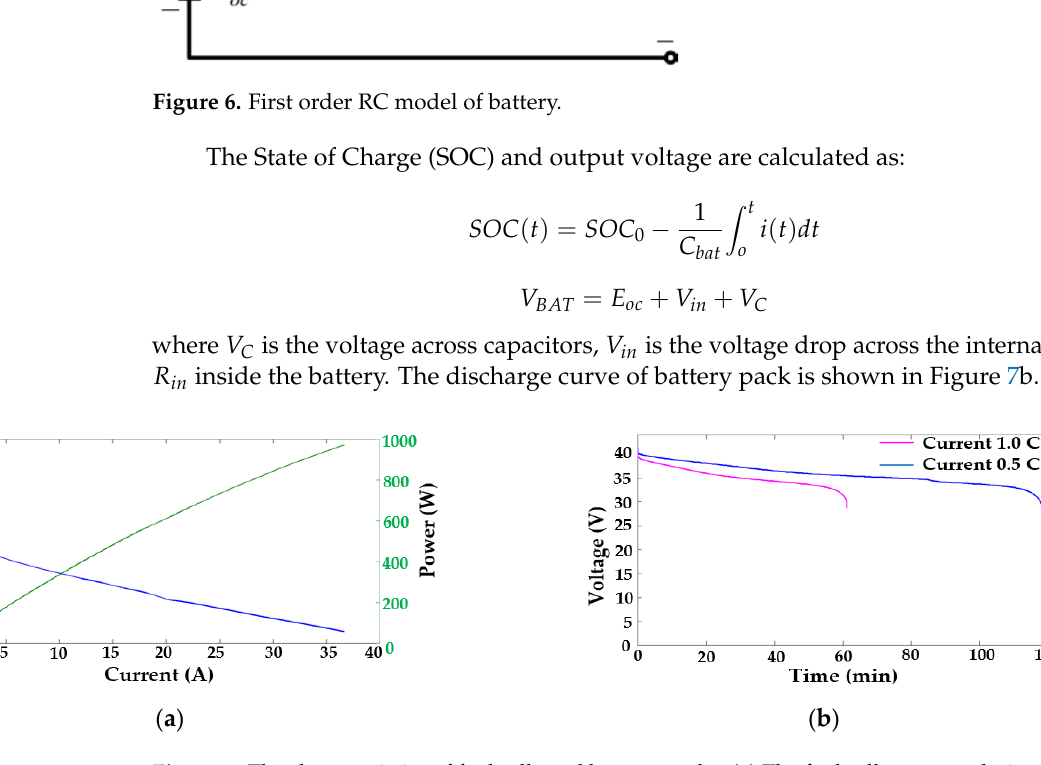
Figure 7 . The characteristics of fuel cells and battery packs. ( a ) The fuel cell output polarization curve. ( b ) The discharge curve of the battery pack.